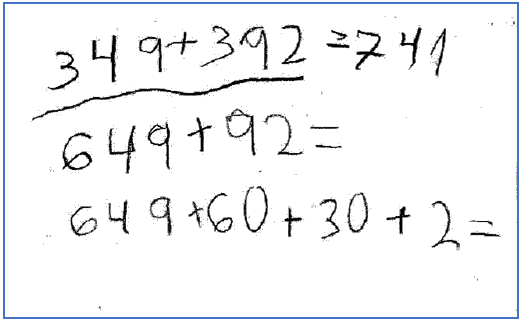
Figure 36. Work out 349 + 392.